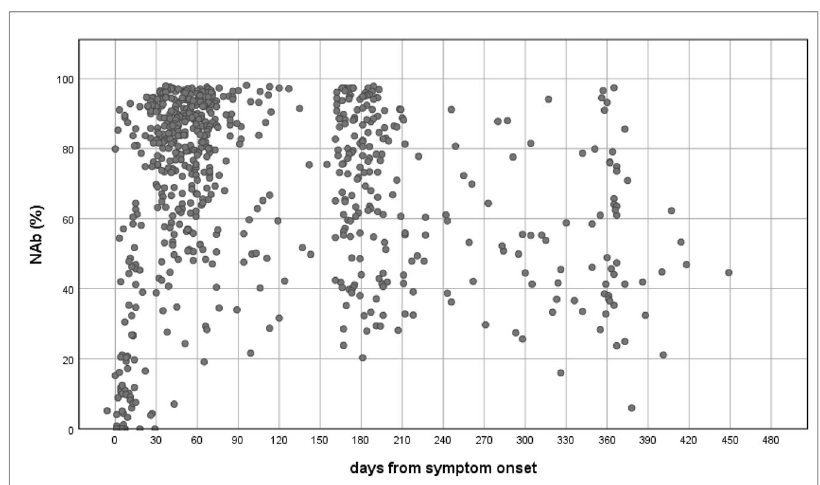
Fig. 1 Scattered plot for neutralising antibody (NAb) levels (%) over days from symptom onset among 341 symptomatic patients. NAb — neutralising antibody.